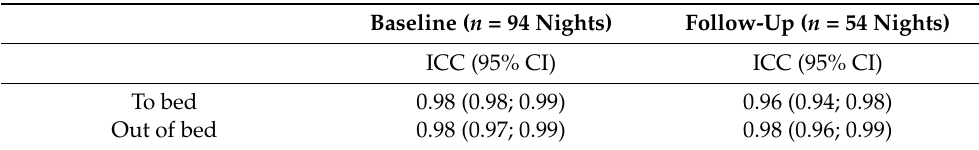
Table 4. Intraclass correlation coefficients between self-report and ZM.